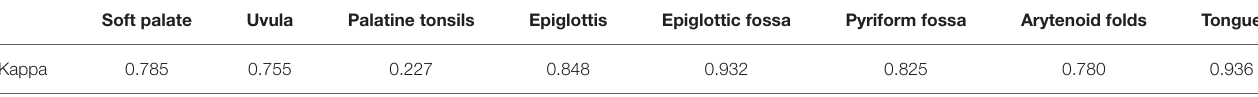
TABLE 1 | Consistency test of the scores between the two observers.